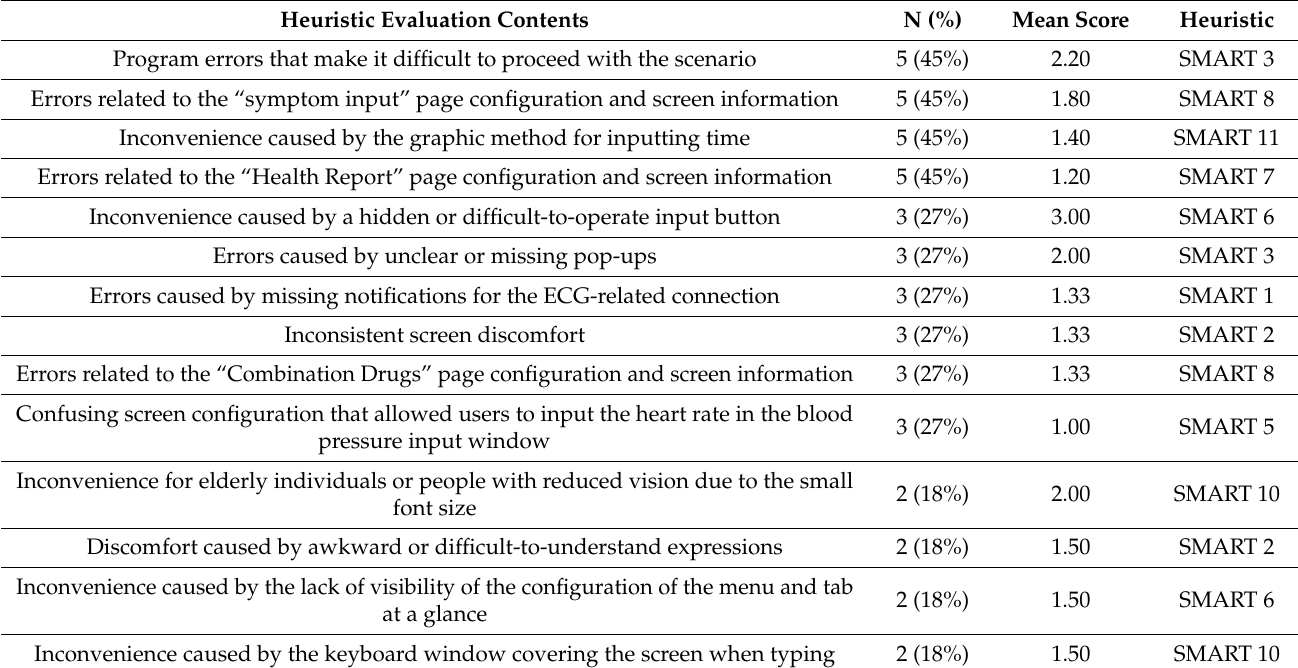
Table 3. Results of the heuristic evaluation of the clinical trial monitoring